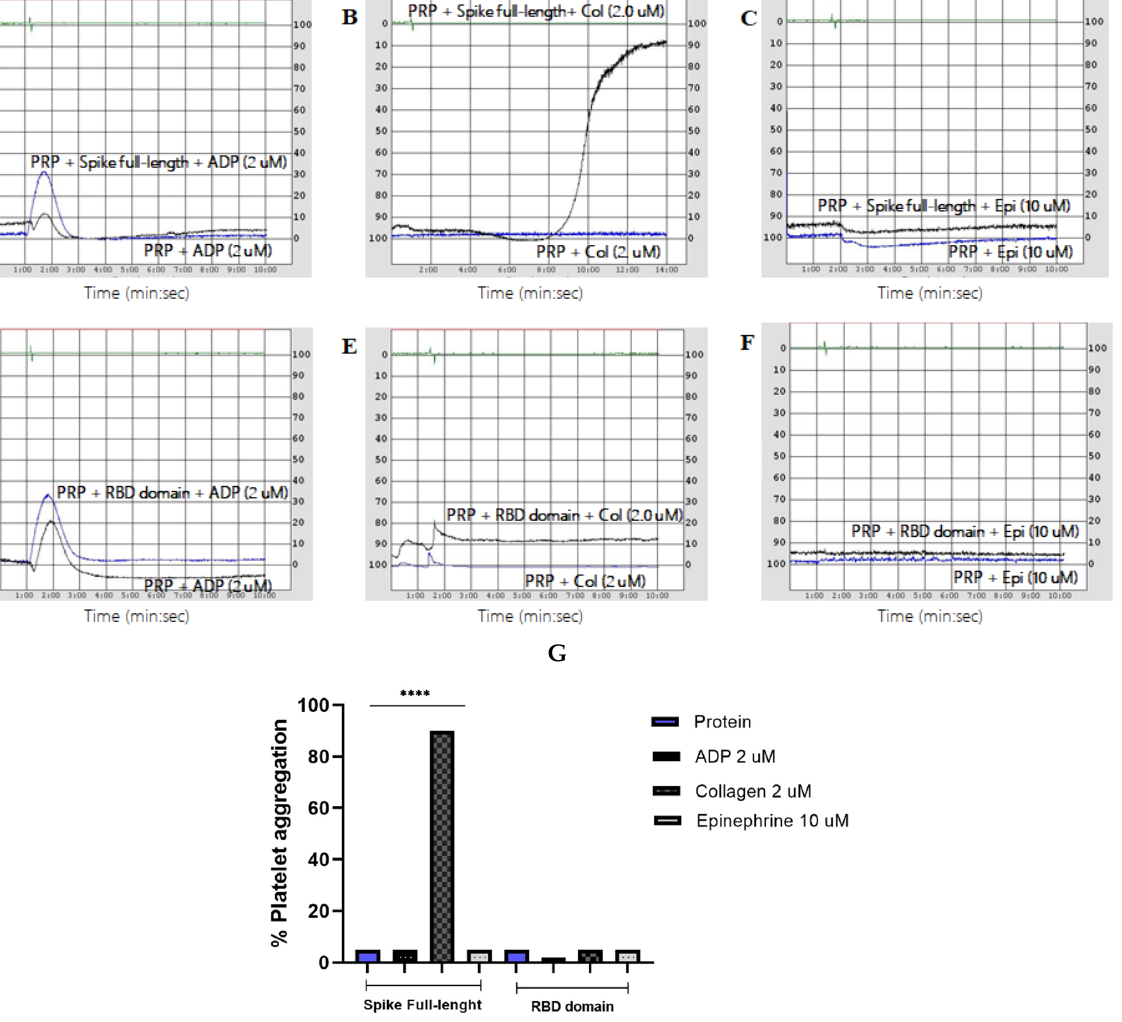
Figure 3. Determination of the aggregation capacity of platelets incubated with spike full-length or RBD domain in response to subthreshold doses of known aggregation agonists ( A – C ). PRP was incubated with spike full-length protein (2.0 µ g/mL) for 30 min and a dose of 2 µ M ADP, 2 µ M collagen, and 10 µ M epinephrine was added. Only the minimal dose of collagen was able to induce aggregation of PRP when compared to the negative control (PRP + 2 µ M ADP, 2 µ M collagen, and 10 µ M epinephrine, respectively) ( D – F ). PRP was incubated with RBD domain (2.0 µ g/mL) for 120 min and a dose of 2 µ M ADP, 2 µ M collagen, and 10 µ M epinephrine was added ( G ). Comparison of platelet aggregation induced by minimal doses of known agonists in PRP incubated with full-length spike or RBD proteins when compared to PRP added with minimal doses of known aggregation agonists. None of the known agonists were able to induce aggregation of PRP when compared to the negative control (PRP + 2 µ M ADP, 2 µ M collagen, and 10 µ M epinephrine, respectively). p values were calculated using one-way ANOVA and Tukey’s post-hoc tests ( n = 3). Data presented as Mean ± SD. ****: Statistical difference p <